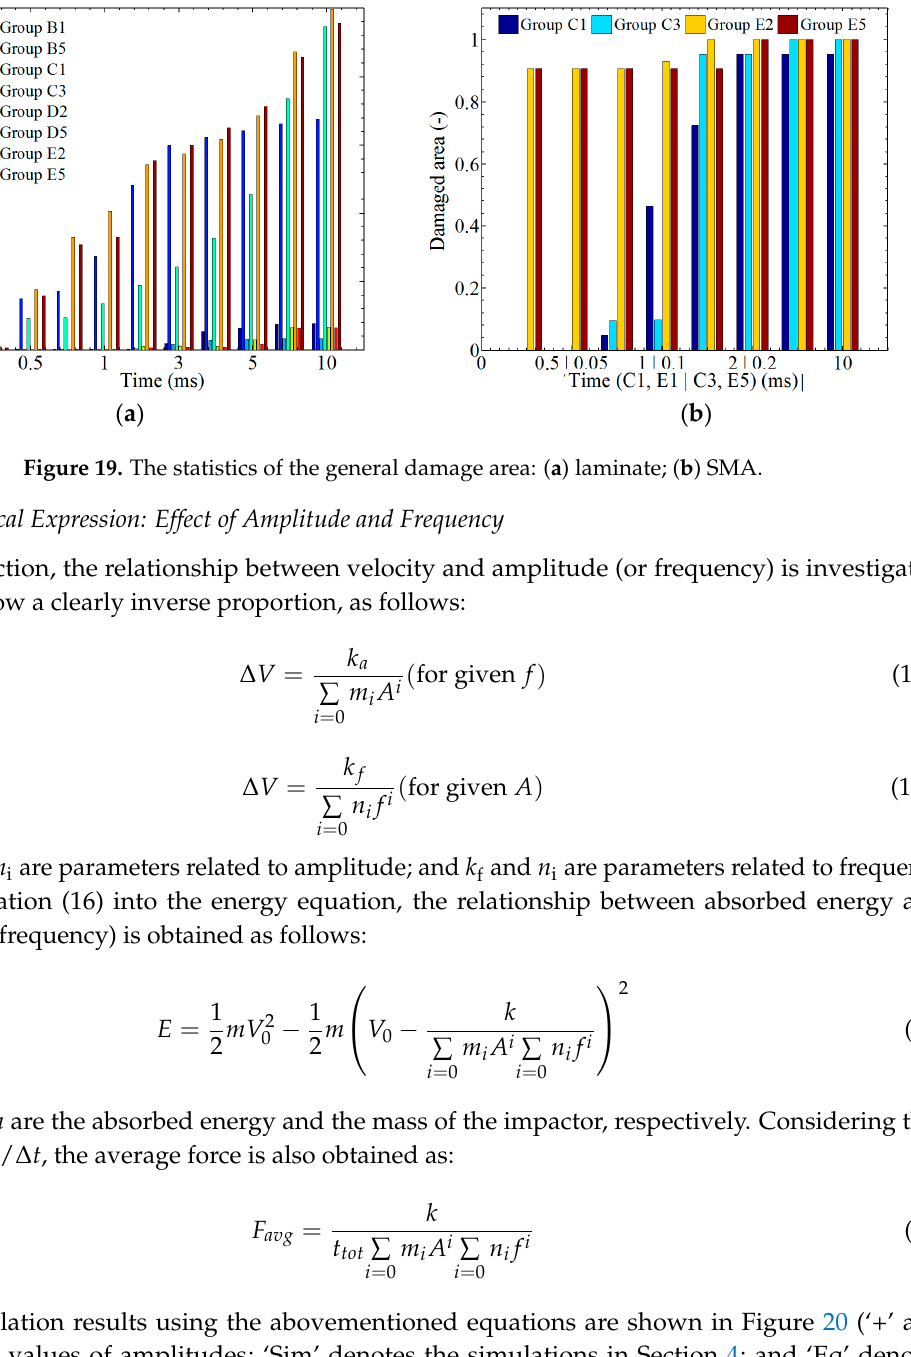
Figure 18. The statistics of the damage area in different groups: ( a ) layer 16; ( b ) layer 8; ( c ) layer 1.